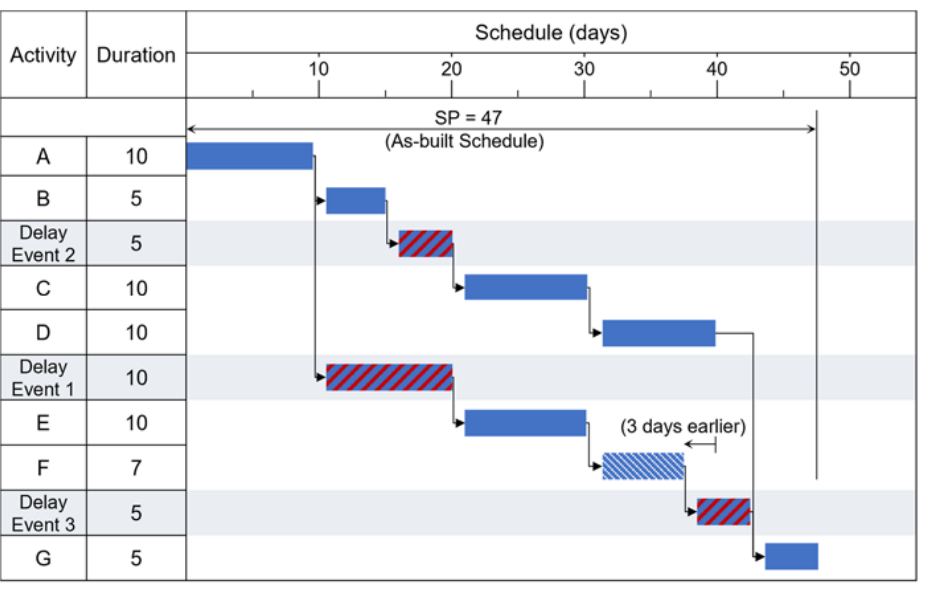
Figure 2. As ‐ built schedule of a sample project. Figure 2. As-built schedule of a sample